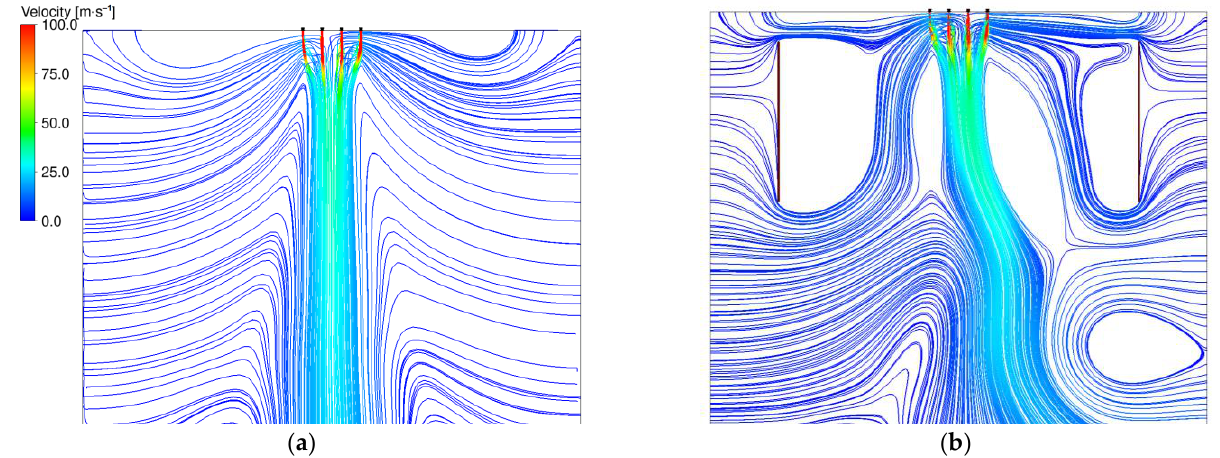
Figure 15. Simulation of the streamlines of process air, starting from the outer boundaries (secondary air) and the nozzles (primary air): ( a ) without air channel; ( b ) with closed air channel.